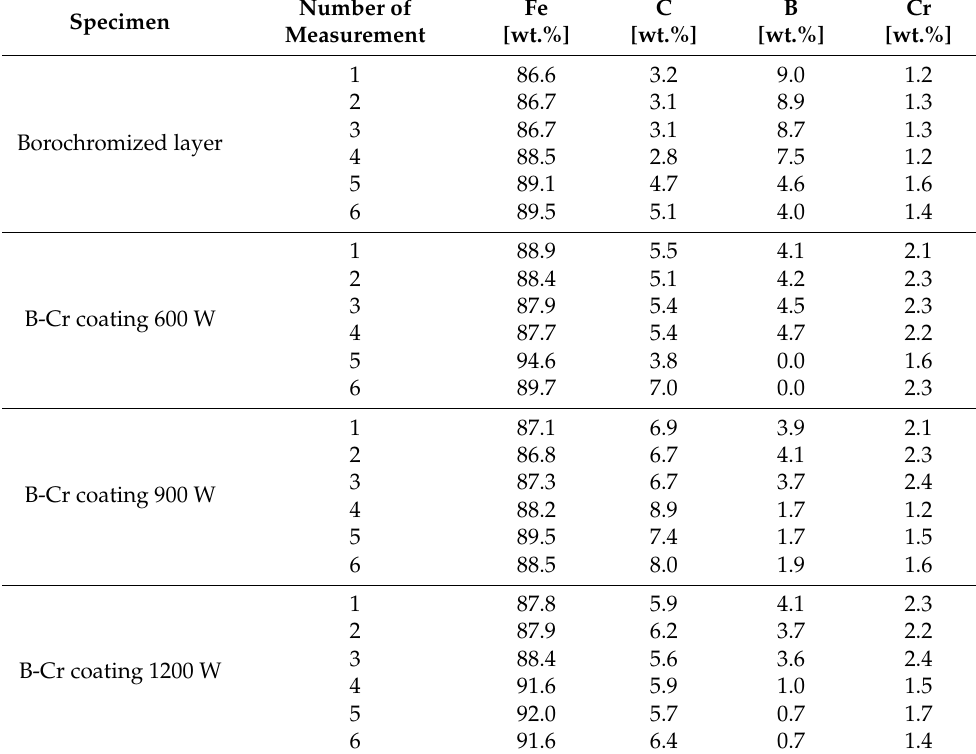
Table 2. Chemical composition (EDS) results from areas marked in Figures 2–5. Number Specimen